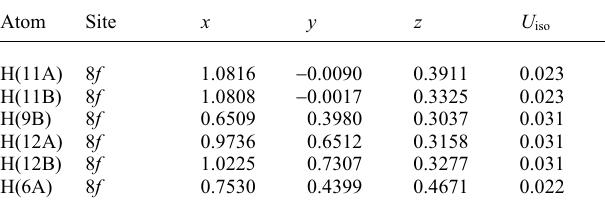
Table 2. Atomic coordinates and displacement parameters (in Å 2 )